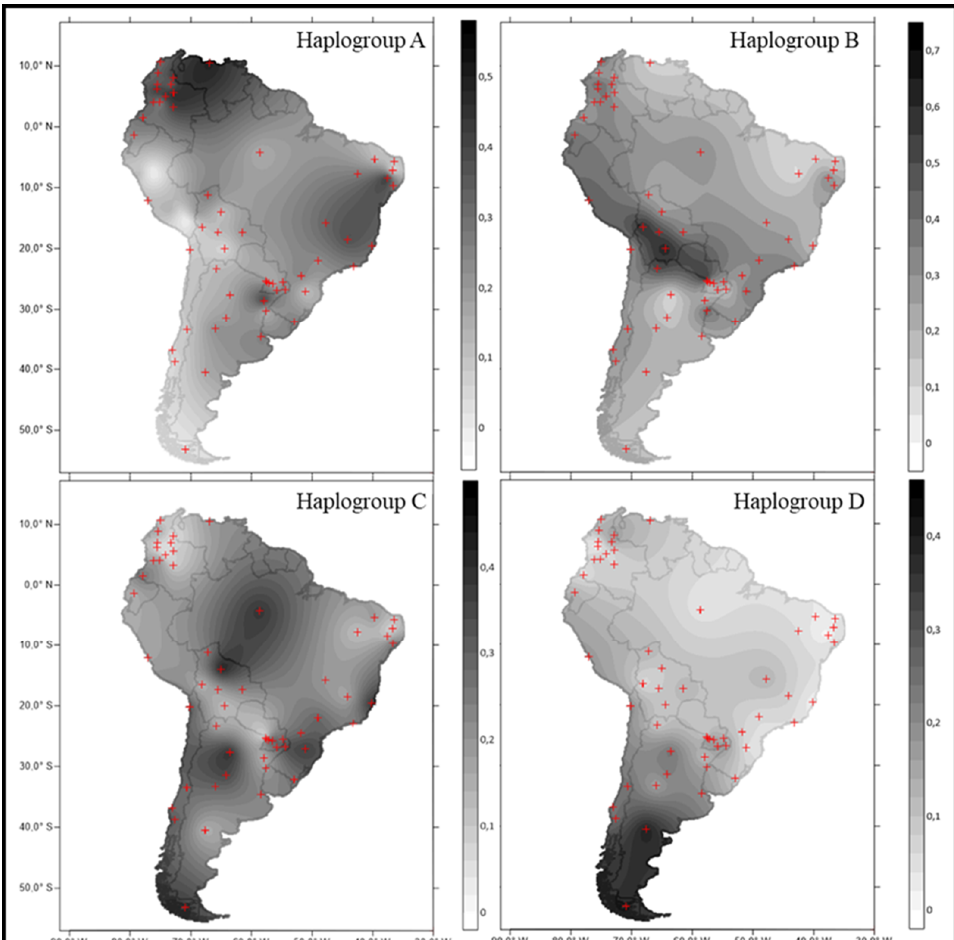
Figure 4 . Frequency distributions of the native macrohaplogroups A, B, C and D in South American admixed populations. Latitude and longitude are represented at the left and bottom sides, respec- tively. Haplogroup frequencies are represented in grey scale according to the legend in the right side of the box. To facilitate interpretation, frequencies are scaled differently for each haplogroup. Red dots represent the location of population used (see Supplementary Table S3).